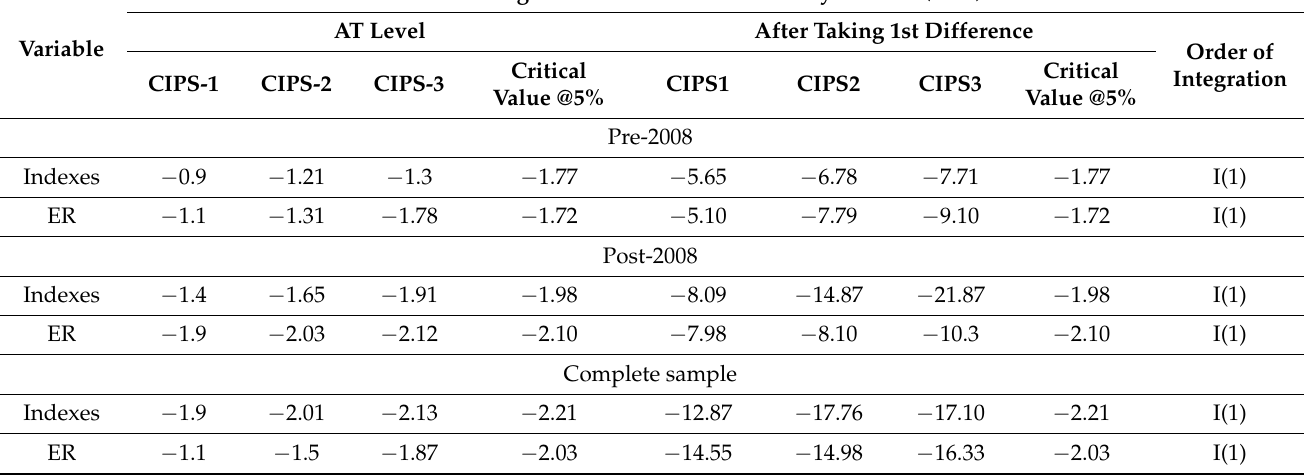
Table 5. Second-generational panel-based unit root estimation in presence of cross-sectional depen- dence by Pesaran